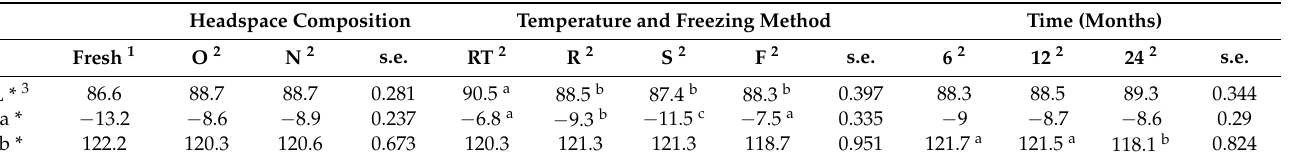
Table 2. Effect of headspace composition, storage temperature and freezing method and storage time on the chromatic coordinates L * a * b * (study I).